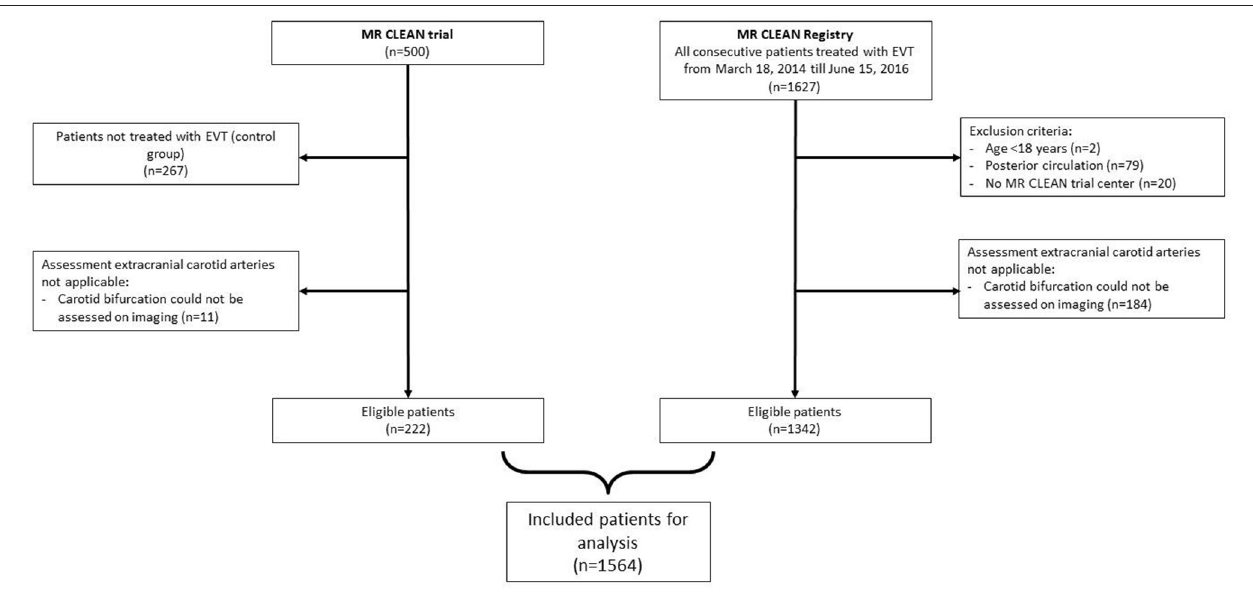
FIGURE 1 | Flowchart of included patients for